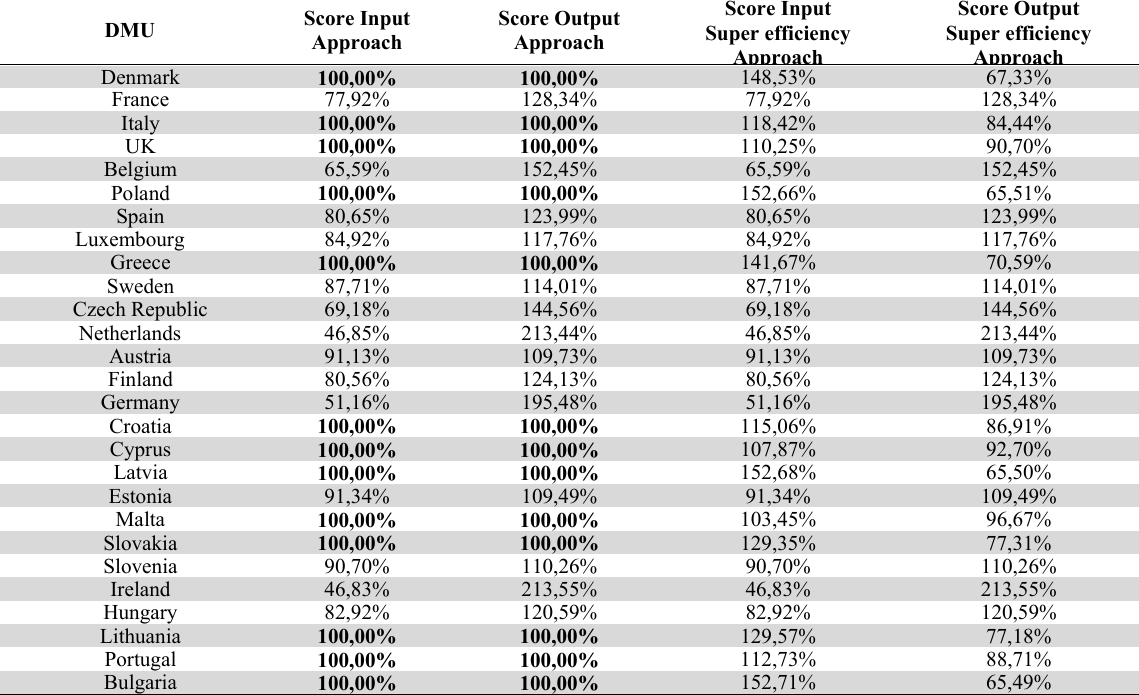
Efficiency Scores According to CCR